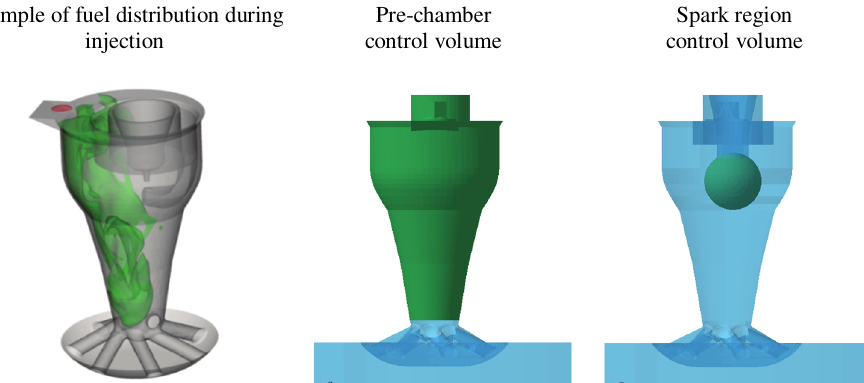
Fig. 2. Left: Example of fuel distribution from LES during the injection event. Centre: Definition of pre-chamber control volume drawn in green. Right: Definition of spark-plug region is a sphere with a 3 mm